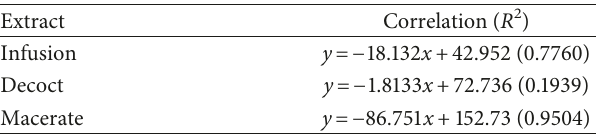
Table 5: Correlations between total antioxidant capacity and total phenolic content of extracts obtained from different aerial parts of Rudbeckia triloba .